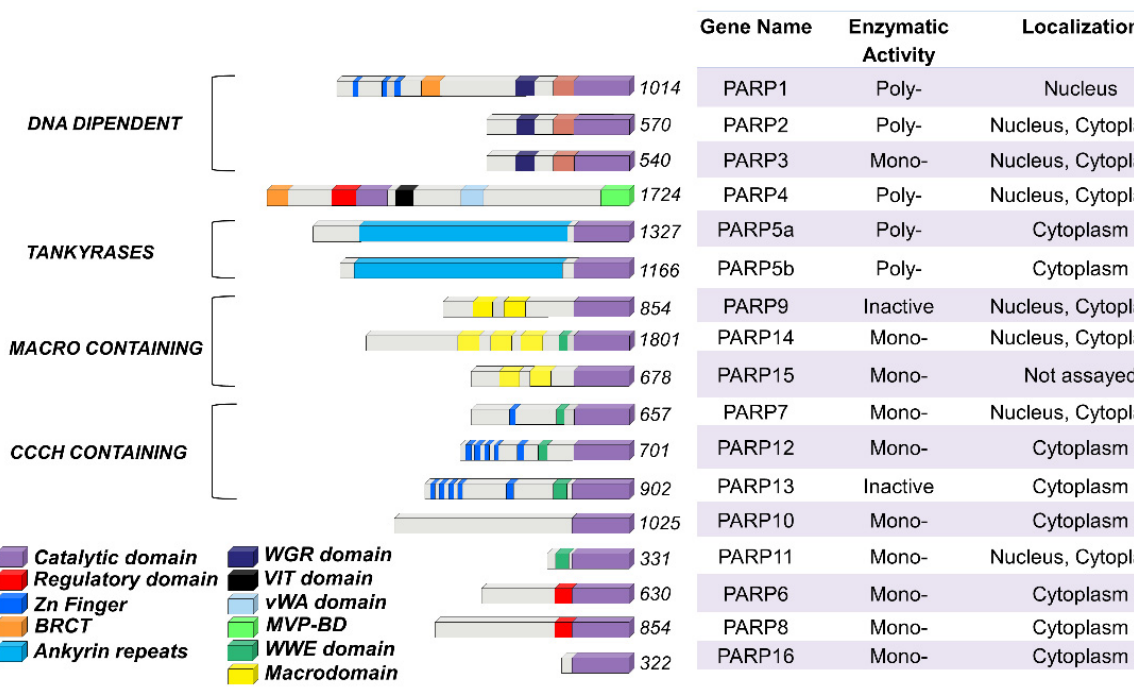
Figure 1. PARP family members functional domains . The structures are schematized in colored bars and their specific enzymatic activity including: Mono-, Poly-(ADP)ribose polymerases or Inactive is also reported.